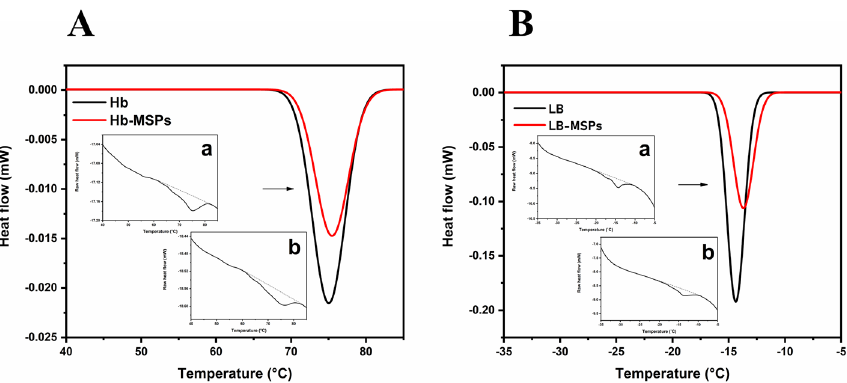
Figure 8. ( A ) A typical differential scanning calorimetry (DSC) thermal denaturation profile for free Hb and Hb − loaded MSPs. Insets (a, b): raw DSC spectra for free Hb (a) and Hb − loaded MSPs (b). ( B ) DSC thermograms of empty liposomes and lipid − bilayer-coated MSPs. Insets (a, b): raw DSC spectrum for empty liposomes (a) and liposome − encapsulated MSPs (b). Heating rate, +10 °C/min. Table 1. Thermodynamic profiles of the denaturation peaks of Hb and Hb-loaded MSPs, and phase transitions of liposomes and liposomes incubated with MSPs (in 1 mM phosphate buffer, pH 7.4). Sample T m (°C) Hb 75.72 ± 0.9 Hb-loaded MSPs 76.73 ± 0.5 Empty liposomes − 14.08 ± 0.1 Liposome-encapsulated MSPs − 13.07 ± 0.4 Data are means ± SD.